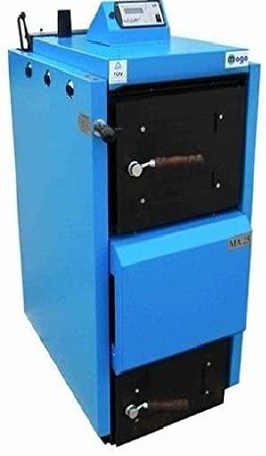
Fig. 3 . Solid biomass gasification boiler